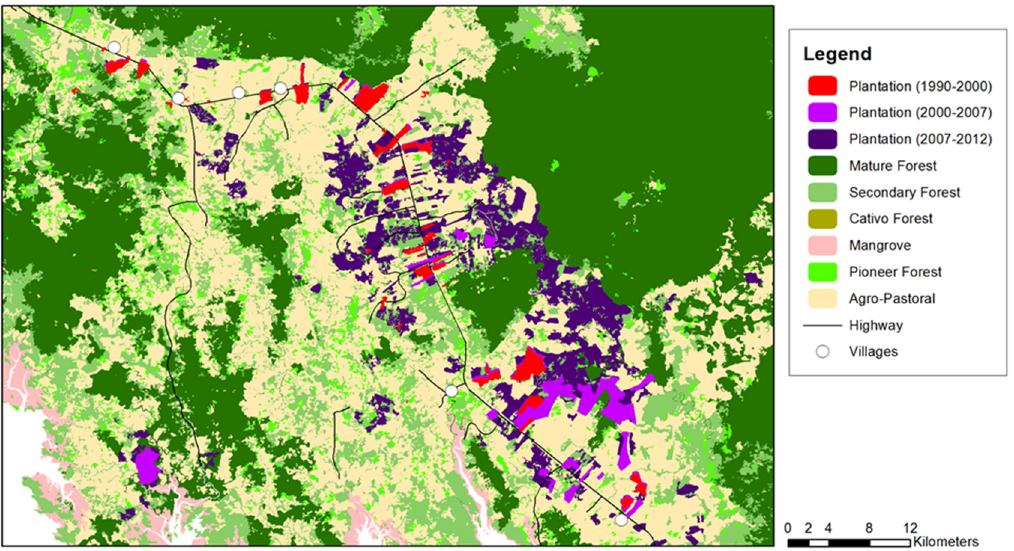
Figure 7. Land Cover in the Bayano ‐ Darién Region, 2012.